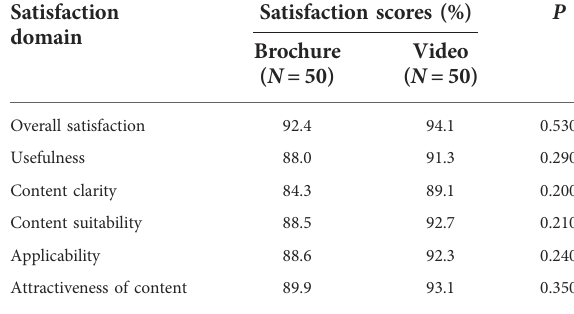
TABLE 4 Patient satisfaction between the brochure and the video